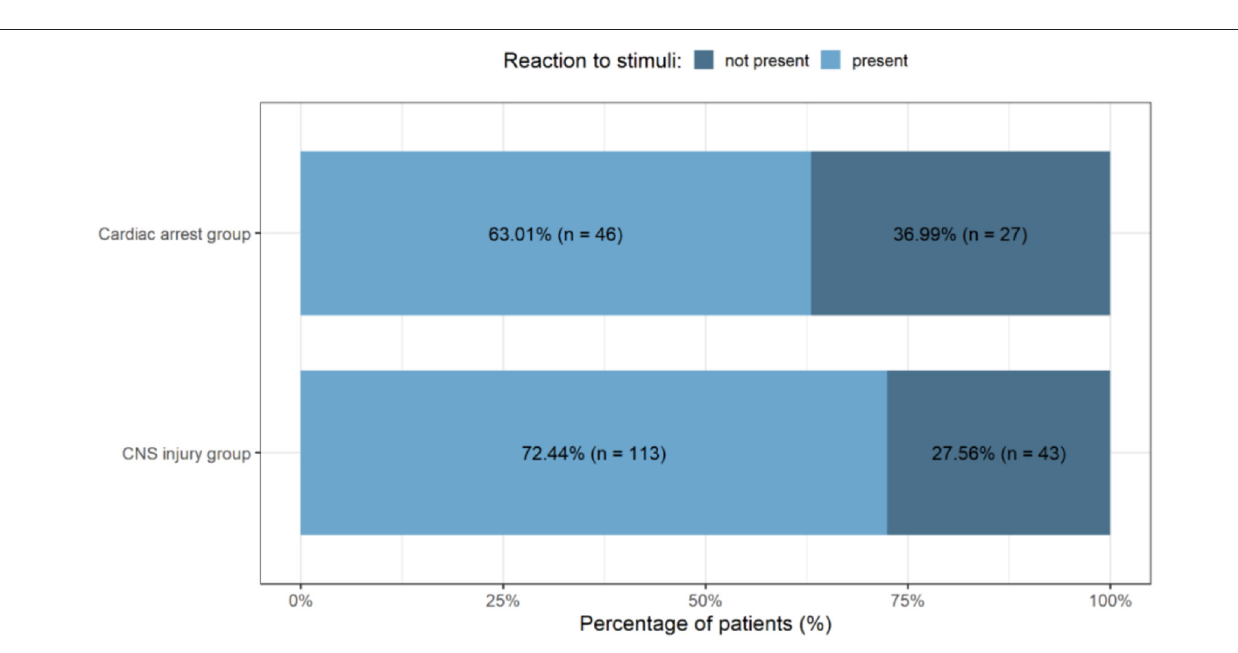
FIGURE 5 | Presence of a reaction to external stimuli in the neurological group of patients and in the cardiac arrest (DCD) group. CNS, Central Nervous